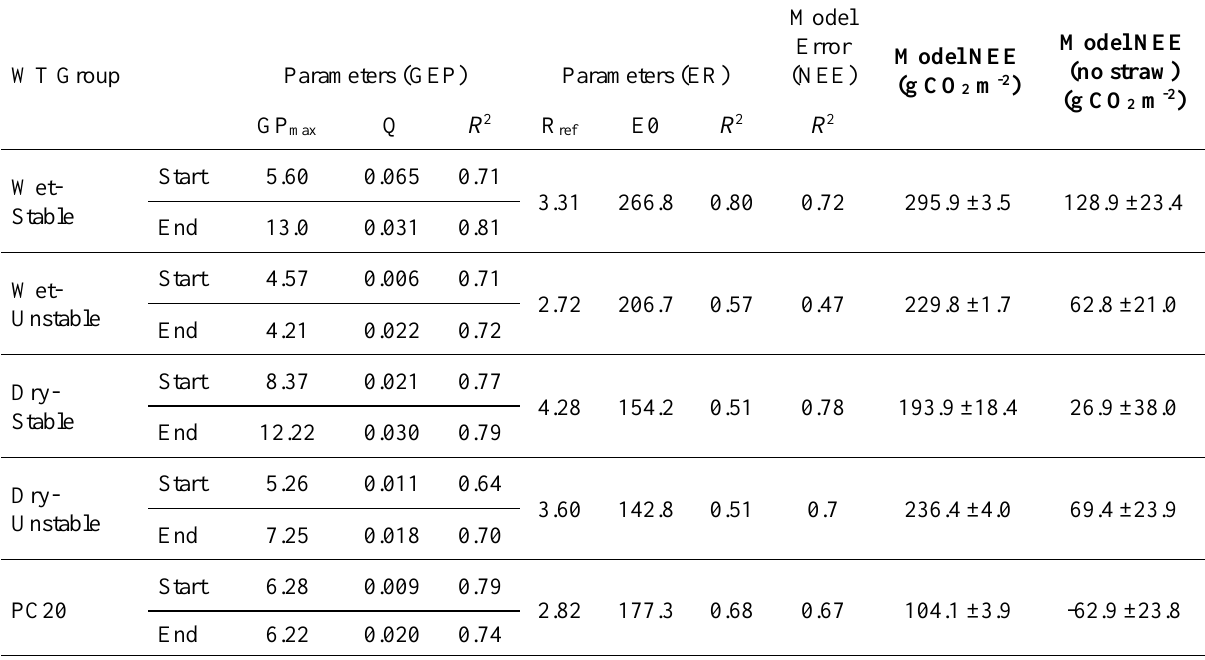
Table 2. Model parameters and estimated total seasonal NEE and straw